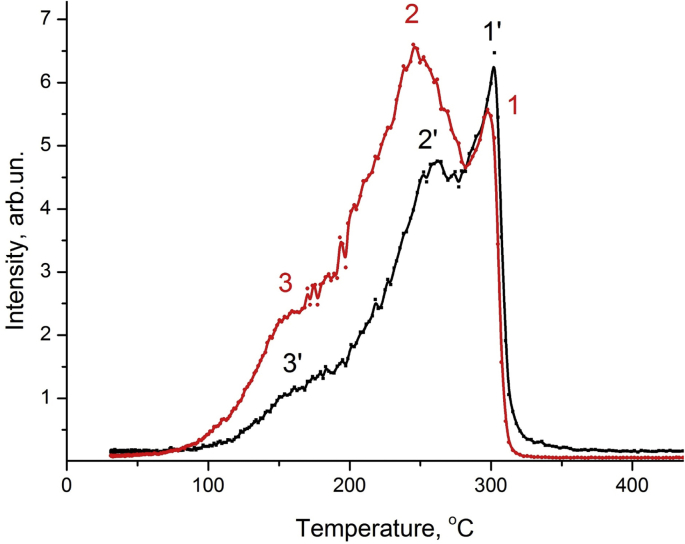
Hydrogen isotopes release: H (1′-3′) and D (1–3) from the closed loop of Pd at the linear heating mode (heating rate = 1°C·s−1) by a quartz coaxial furnace (j = (30–70) А сm – 2) in a quartz vacuum cell: 1, 1′ peaks are the thermal stimulation contribution: Tmax1 (D2), Tmax1 ‘(H2) = 300 °C; 2, 2′ peaks are the electromagnetic field contribution: Tmax2 (D2) = 246 °C, Tmax2’ (H2) = 262 °C; 3, 3′ peaks are the induced electric current contribution: Tmax3 (D2), Tmax3’ (H2) = 16 °C. Electrolytic saturation of Pd: D2SO4 (0.5 M), t = 90min, I = 100mA, 02.15.2018.